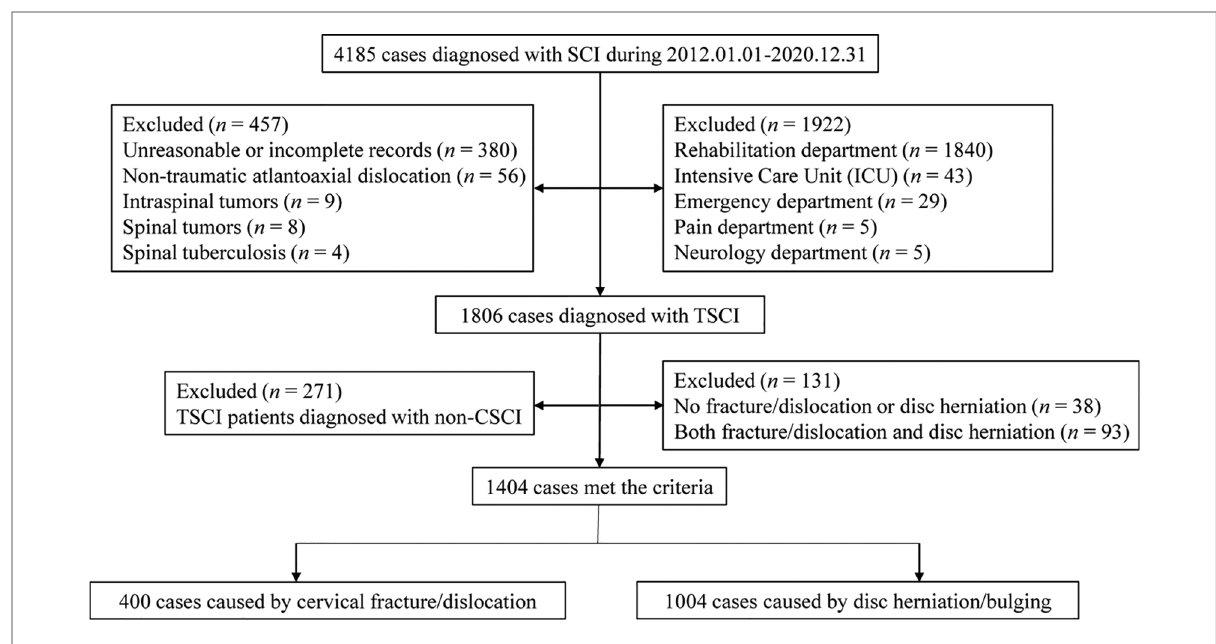
FIGURE 1 Flow chart of patient